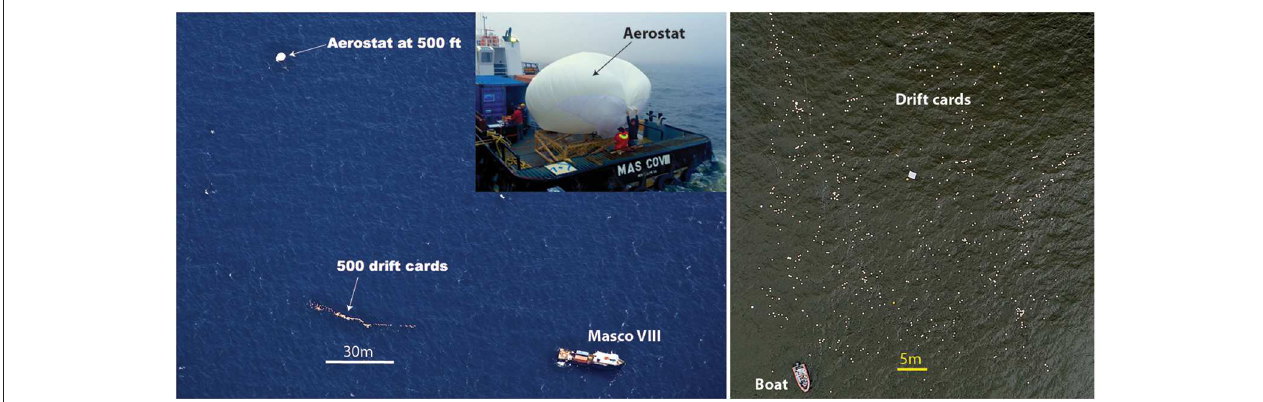
FIGURE 3 | The aerostat is launched from and tethered to a surface ship. Drift cards are released from a small boat and the ship is maneuvered to keep the aerostat over the drift card array using images transmitted from the camera on the aerostat (from Özgökmen et al., 2018).